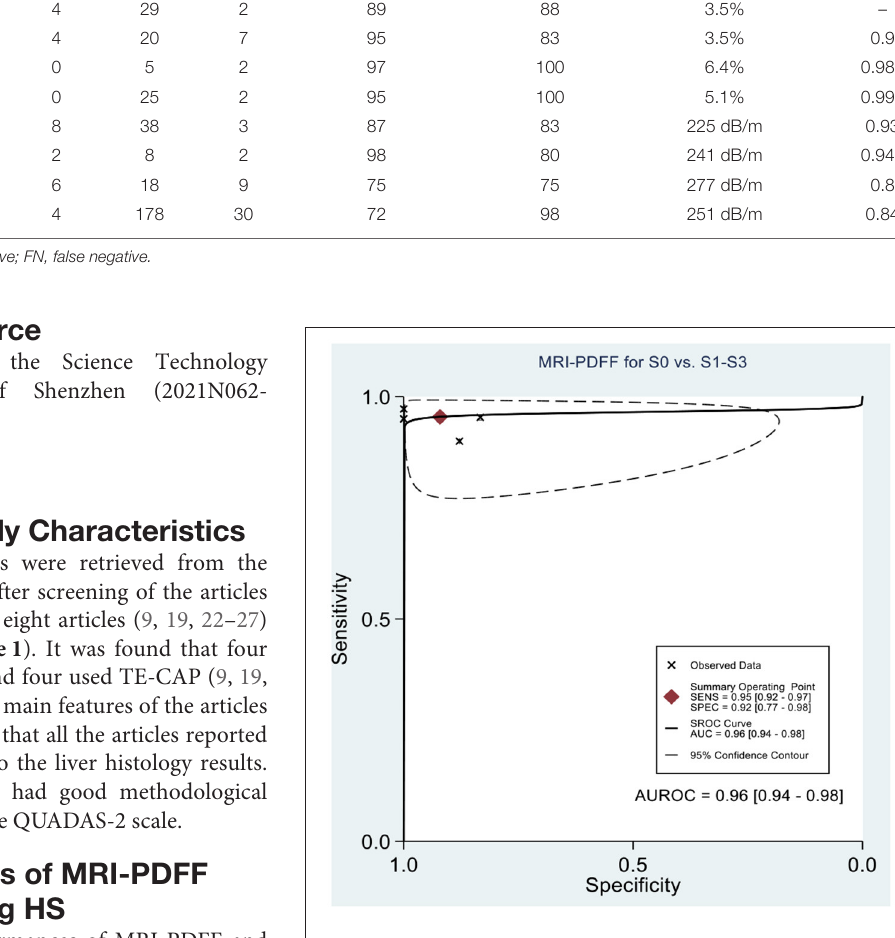
FIGURE 2 | Hierarchical summary receiver operating characteristic (HSROC) curves for the detection of hepatic steatosis (S0 vs. S1–S3) by using MRI-PDFF or